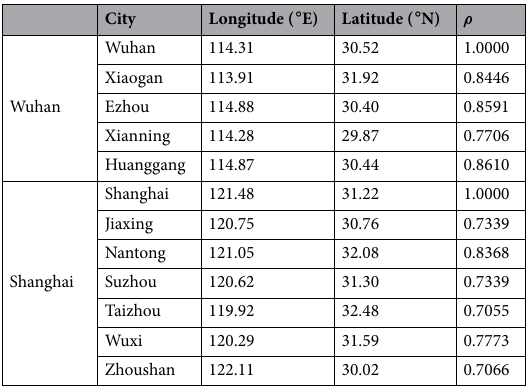
Table 5. The latitude, longitude and ρ of the target site and their spatially correlated sites.